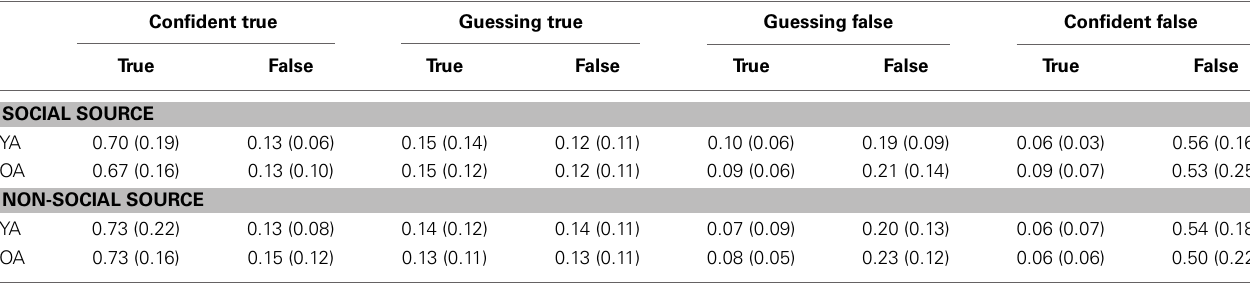
Table 2 | Behavioral source memory performance [ M , ( SD )] for young (YA) and older (OA) adults. Confident true Guessing true Guessing false Confident